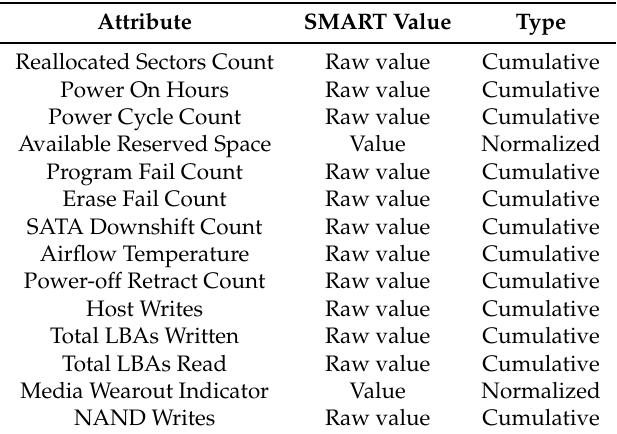
Table 4. SMART Attributes.